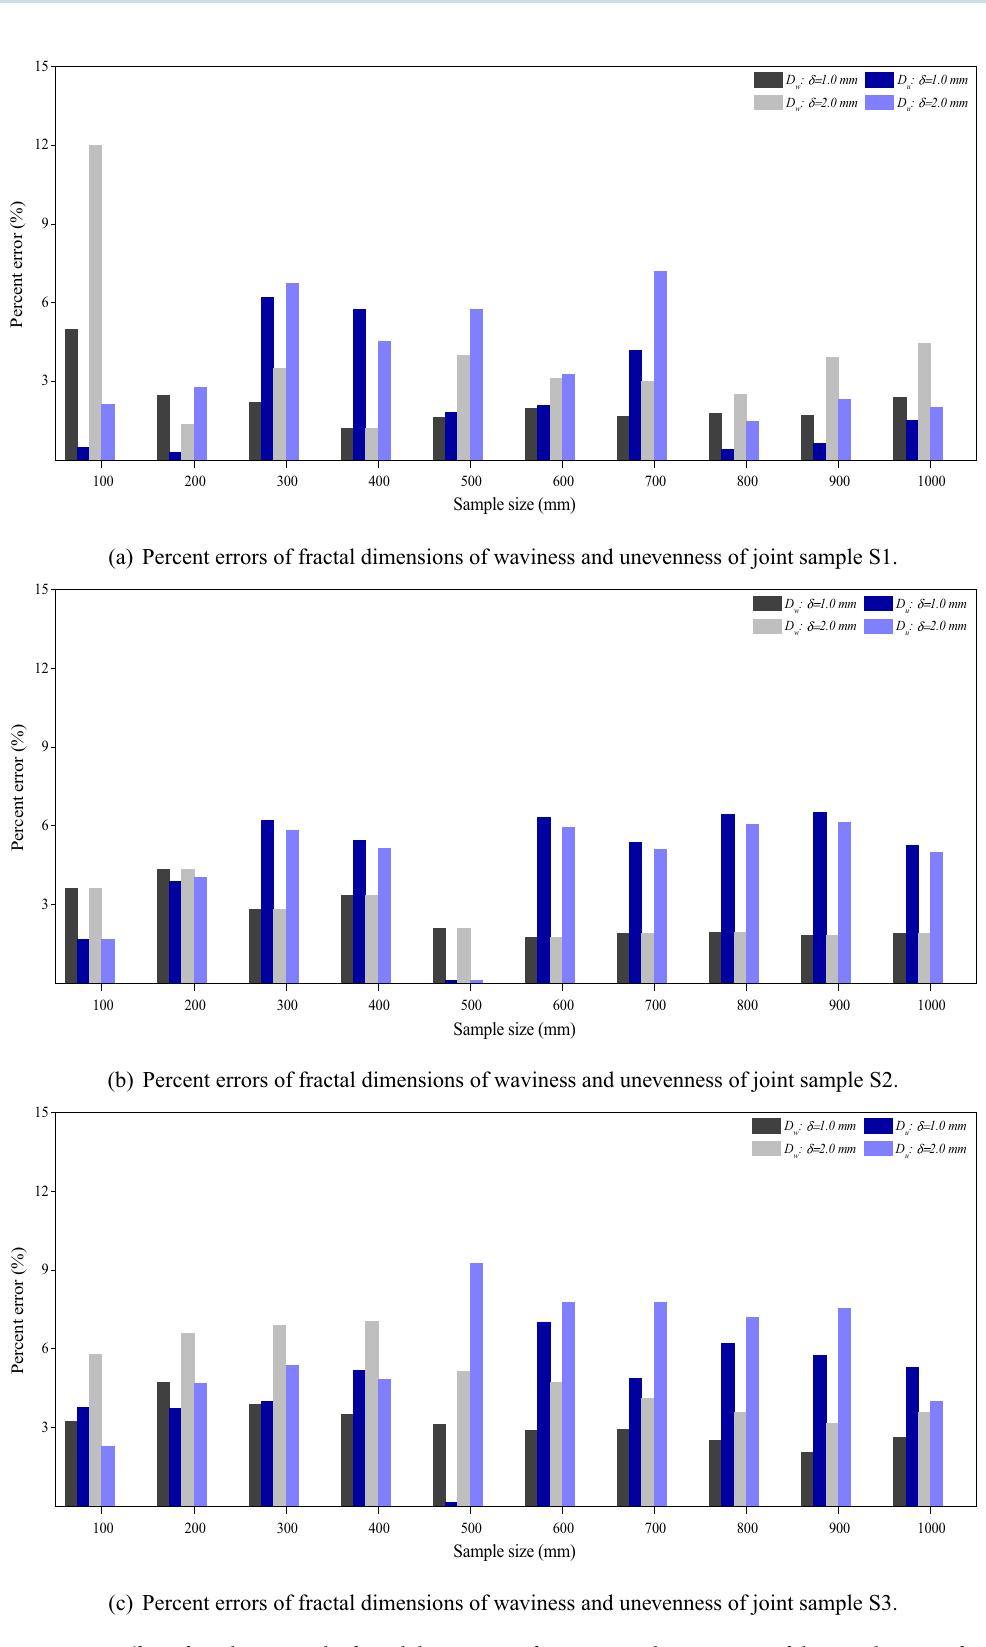
Figure 12. Effect of resolution on the fractal dimensions of waviness and unevenness of three rock joints of varying sample sizes. Percent errors are calculated relative to the values of resolution of 0.5 mm. D w and D u are fractal dimensions of waviness and unevenness, respectively. δ denotes the